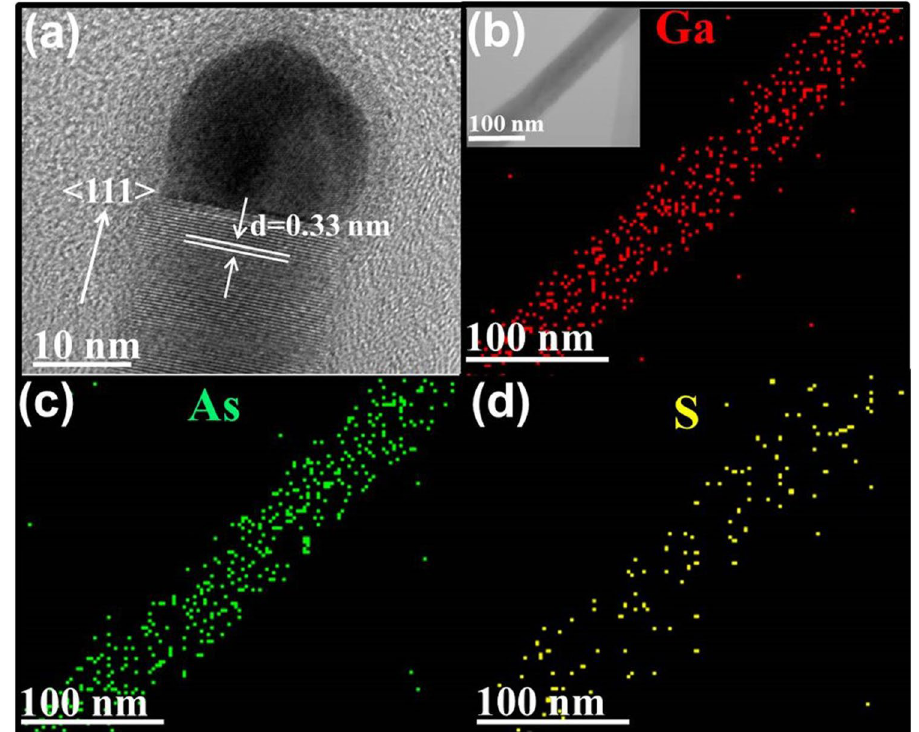
Figure 2. Electron microscopy characterization of thin sulfur-assisted grown GaAs NWs. ( a ) High-resolution transmission electron microscope (HRTEM) image of a representative NW, illustrating the catalyst seed/body region. The diameter is ~23 nm with the growth direction of < 111 > ; ( b – d ) EDS elemental mappings of Ga, As and S, respectively. The inset is the TEM image of an individual NW for collecting the EDS